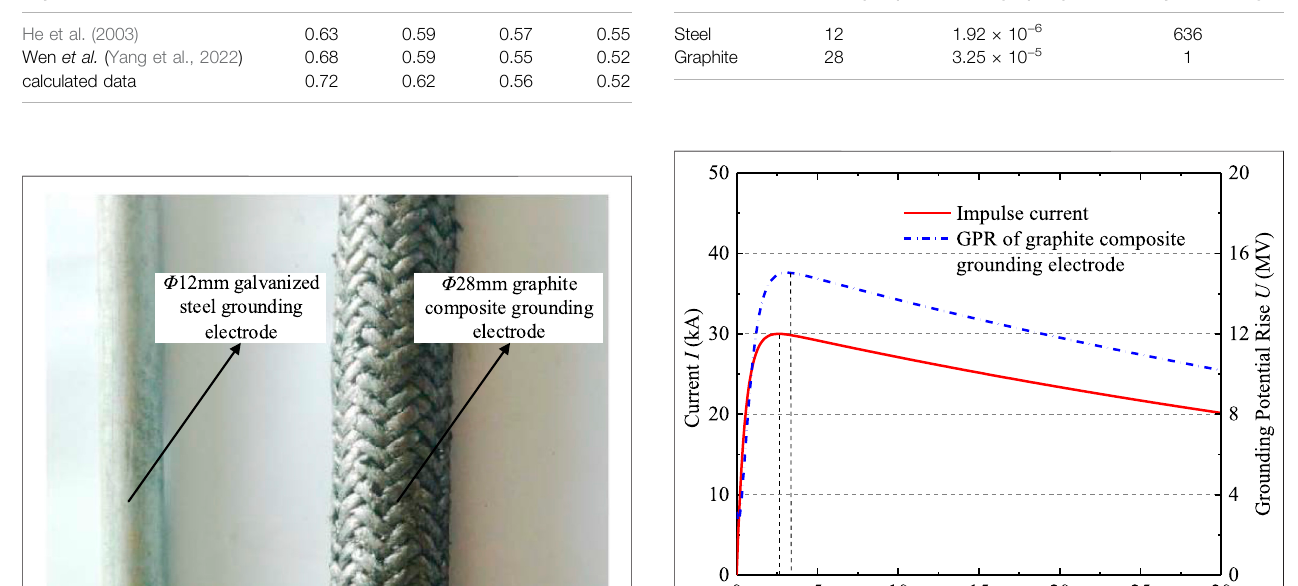
TABLE 1 | Comparison with the impulse coef fi cient α of the experiment. Impulse current